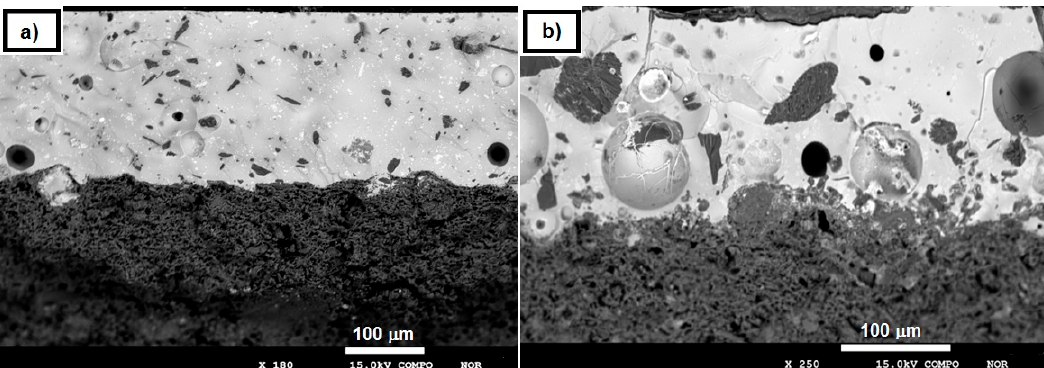
Figure 6. Representative electron microprobe analysis coupled with energy dispersive spectrometry (EMPA-EDS) images showing some morphological features of the VQC2 ( a ) and VQC3 ( b ) samples with evidence of a dual layer, ceramic body/superficial coating.